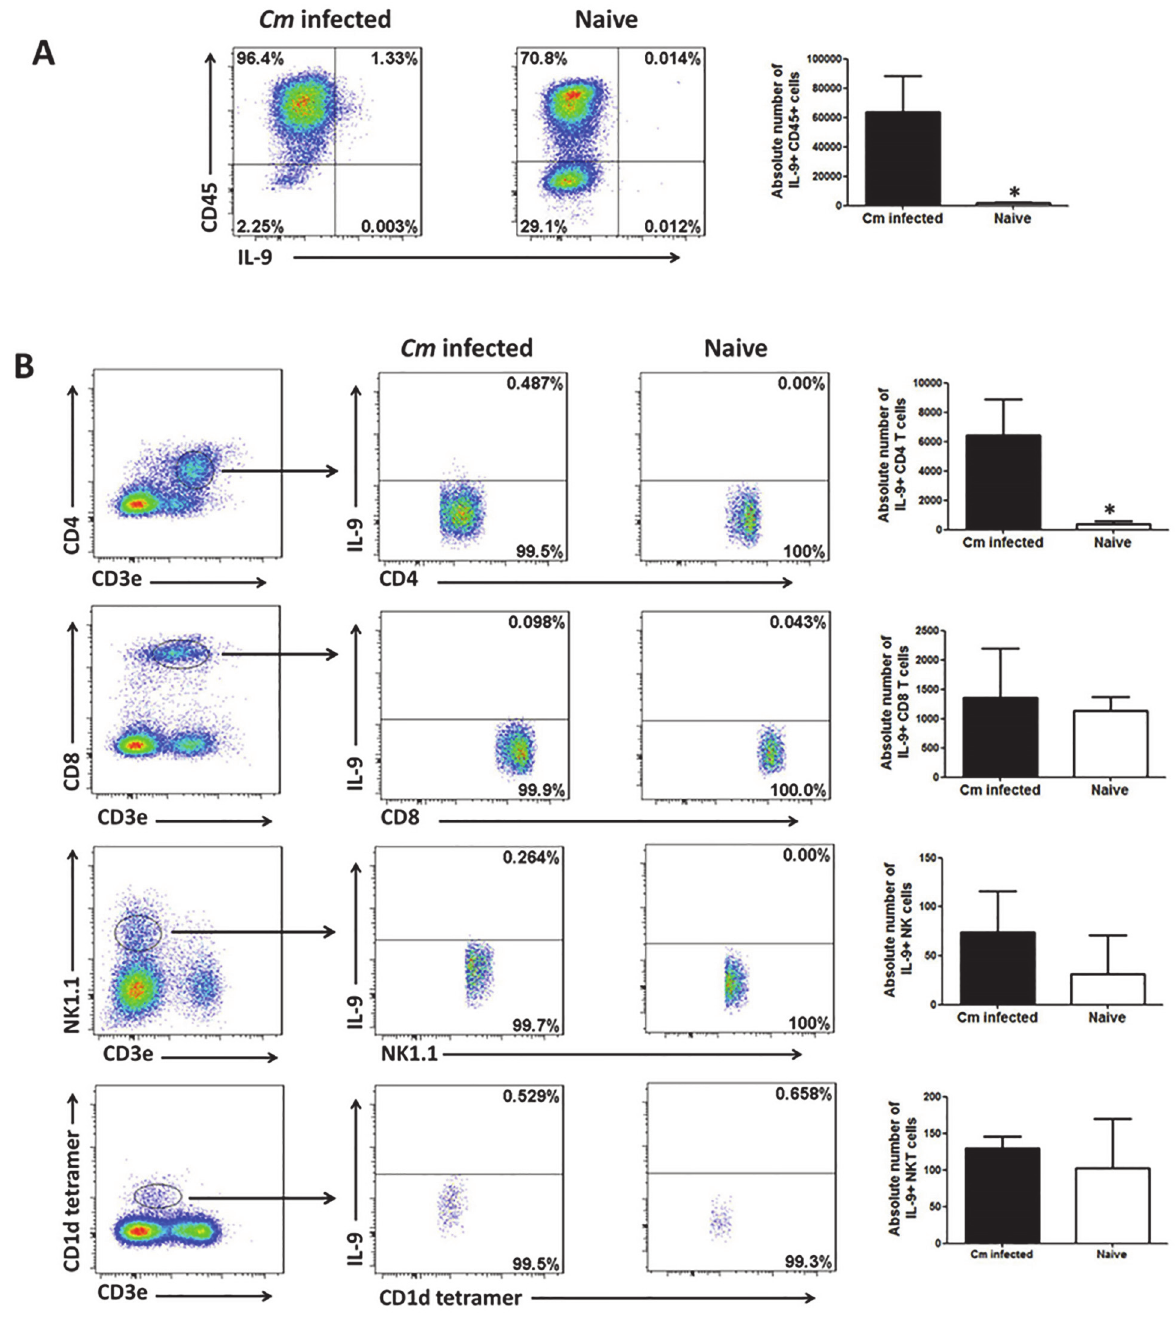
Fig 2. Production of IL-9 by lung mononuclear cells following Cm infection. Mice were inoculated intranasally with Cm (1×10 3 IFUs) and were sacrificed at day 3 post-infection. The isolated lung mononuclear cells were detected for IL-9 expression by FACS. (A) Representative intracellular IL-9 staining of CD45+ cells and absolute number of IL9 producing CD45+ cells in the lung. (B) Representative intracellular IL-9 staining and absolute number of IL-9 producing CD4+ (CD4+CD3+) T cells, CD8+ (CD8+CD3+) T cells, NK (NK1.1+CD3-) cells and NKT (CD1d tetramer+NK1.1+) cells in the lung. One representative experiment of two independent experiments (four mice in each group in each experiment) is shown. The results are shown as mean ± SD ( * , p < 0.05).